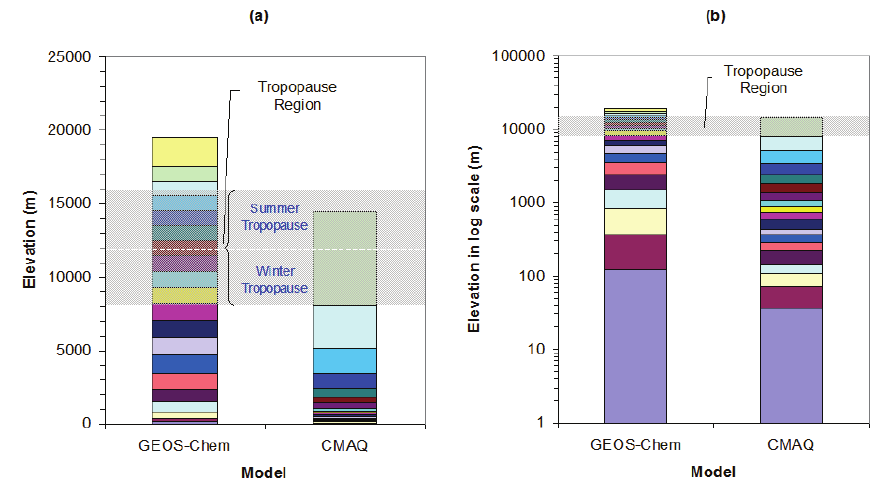
Fig. 1. Vertical layer structure comparison between GEOS-Chem and CMAQ, (a) arithmetic scale, and (b) log scale. BOULDER (40.0N,105.25W)